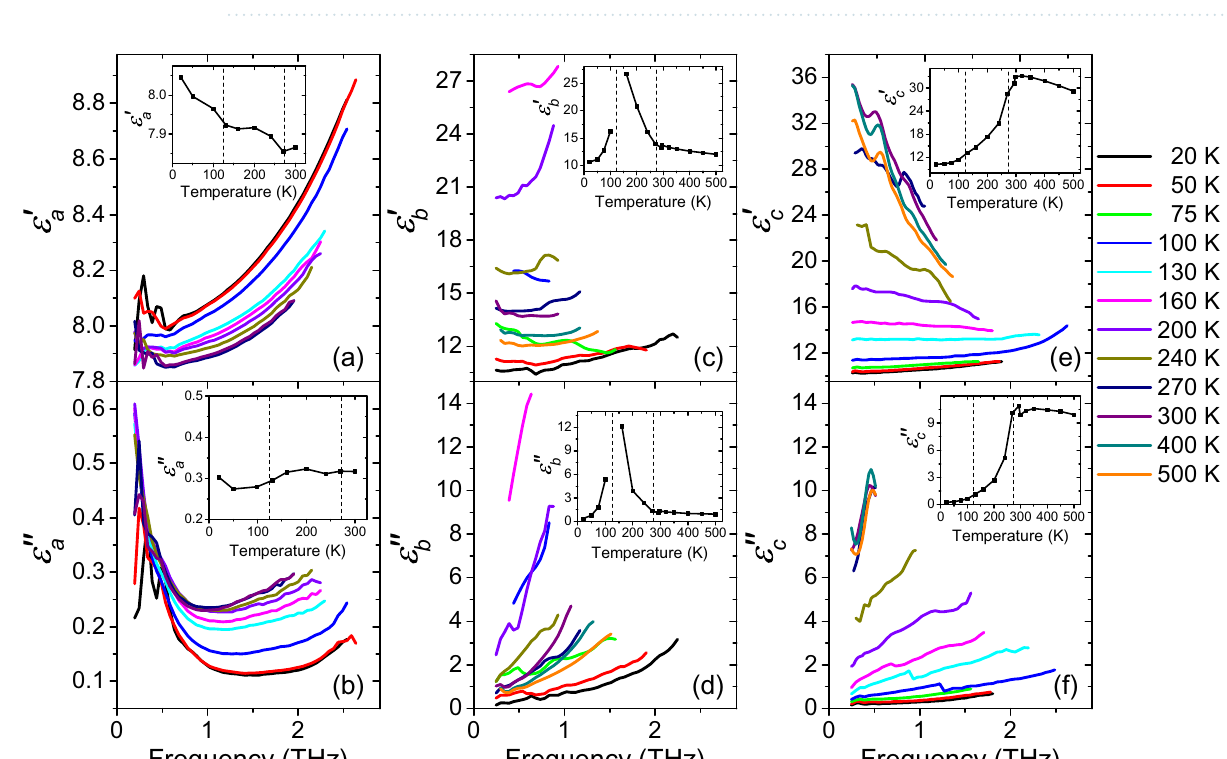
Figure 2. Polarized spectra of complex permittivity of lawsonite in the THz range as a function of temperature. Panels ( a , c , e ): real parts, panels ( b , d , f ): imaginary parts. The insets show temperature dependences of the appropriate values at the frequency of f = 0.5 THz; points: measured values, lines: guides for the